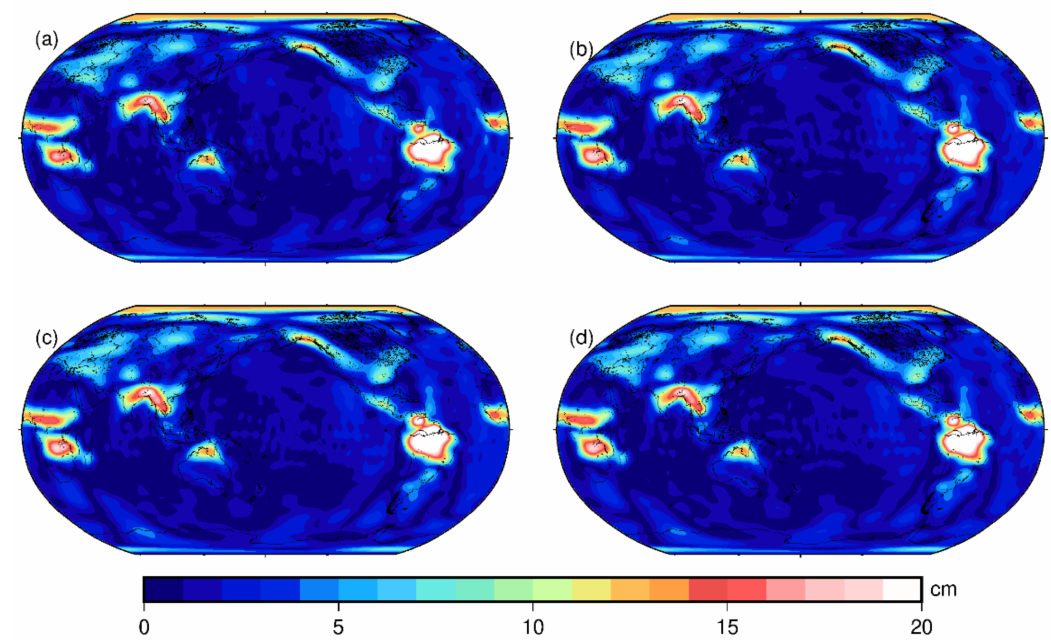
Figure 9. Annual amplitude of global mass change from January 2005 to February 2010 by different time-variable gravity field models (equivalent water height, unit: cm). ( a ) UCAS_IGG; ( b ) CSR; ( c ) GFZ; ( d ) JPL.